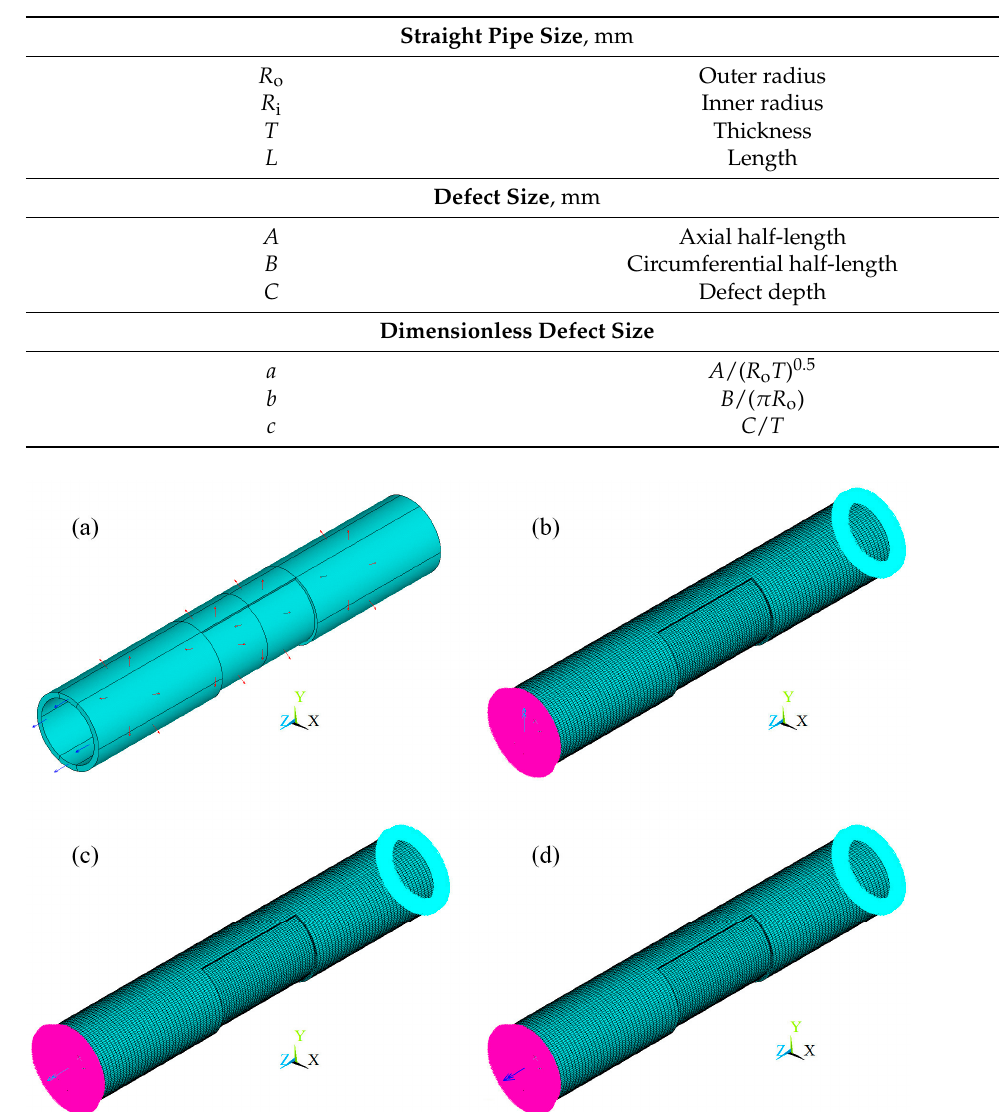
Figure 1. The size model of the straight pipe. Table 1. The straight pipe size and defect size.